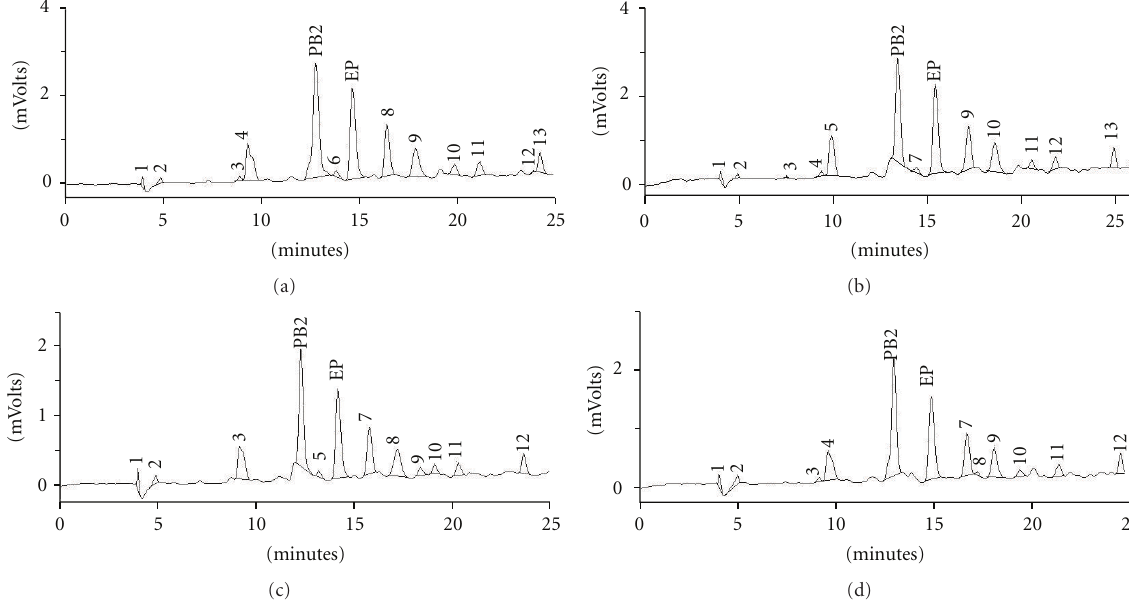
Figure 2: Typical HPLC chromatograms of stress test samples of the crude extract (CE) and the crude extract + colloidal silicon dioxide (CEA) of Guazuma ulmifolia . (a) CE at time zero; (b) CE at day 21; (c) CEA at time zero; (d) CEA at day 21.